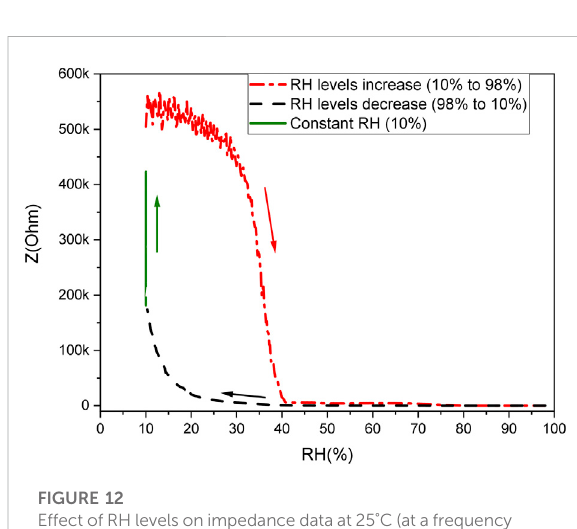
Effect of RH levels on impedance data at 25 ° C (at a frequency of 10